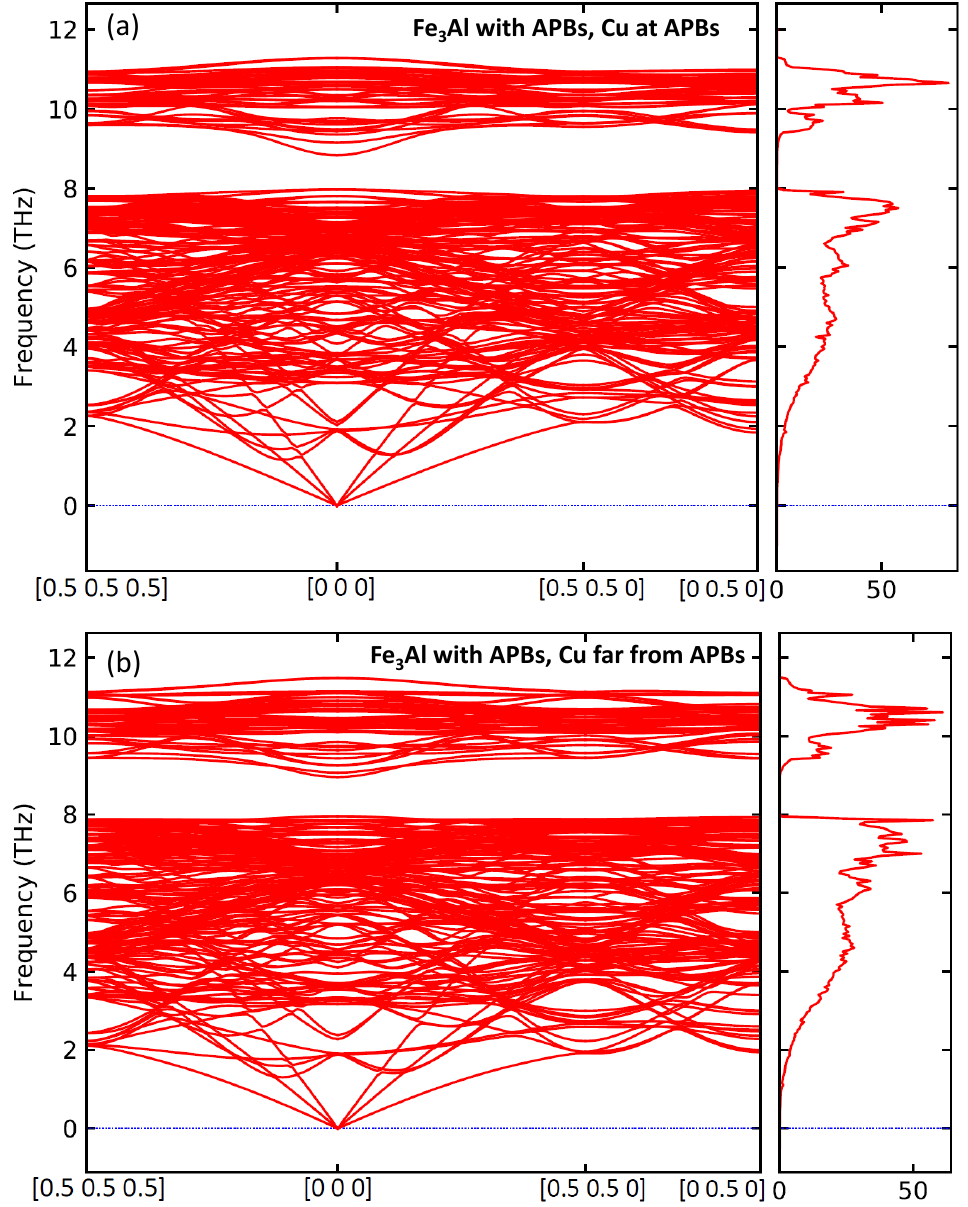
Figure 5. Computed phonon frequencies along selected directions in the reciprocal space and the density of phonon states in Fe 3 Al containing antiphase boundaries (APBs) with the Cu atoms located either within the APB interface plane ( a ) or as far from the APB interface as possible within our computational supercell ( b